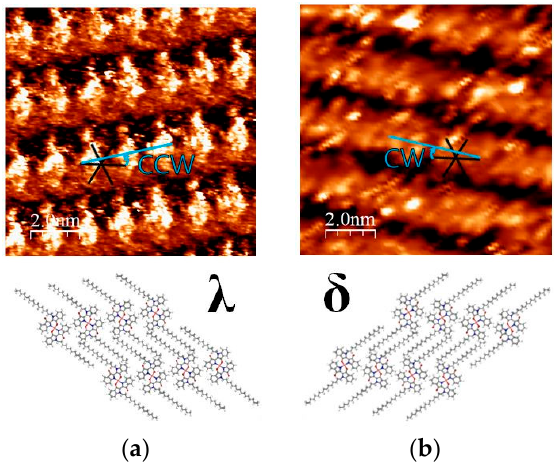
Figure 4. 2D chirality of [Cu(C16IND) 2 ]: ( a ) λ -structure; ( b ) δ -structure.